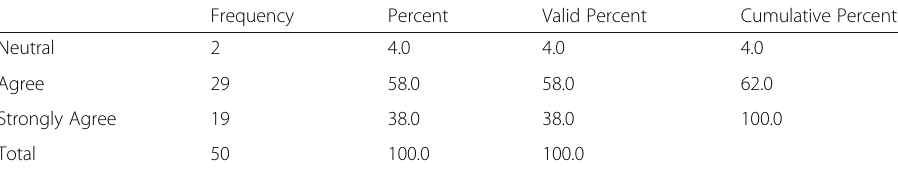
Table 14 Student engagement